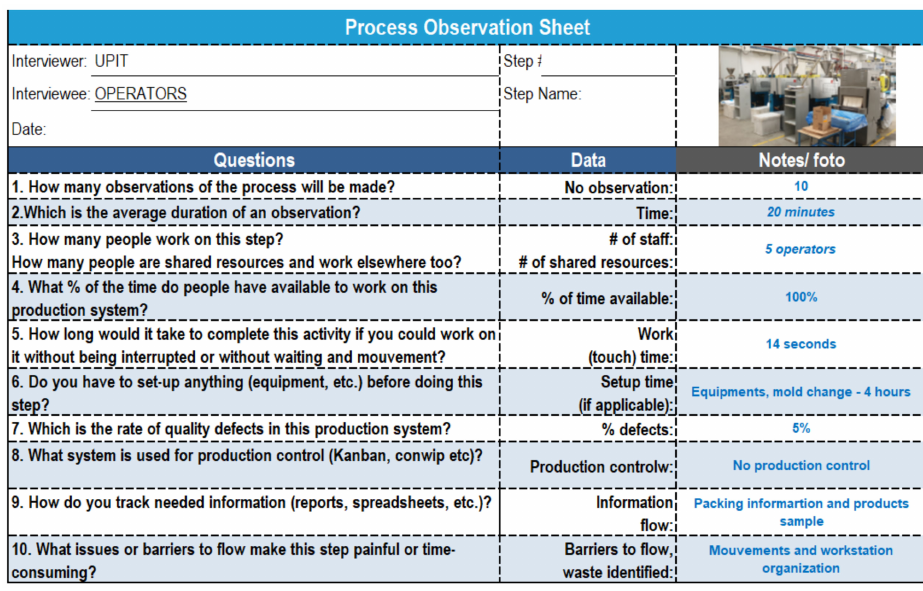
Figure 16. Questionnaire for processes observation of the production system “plastic